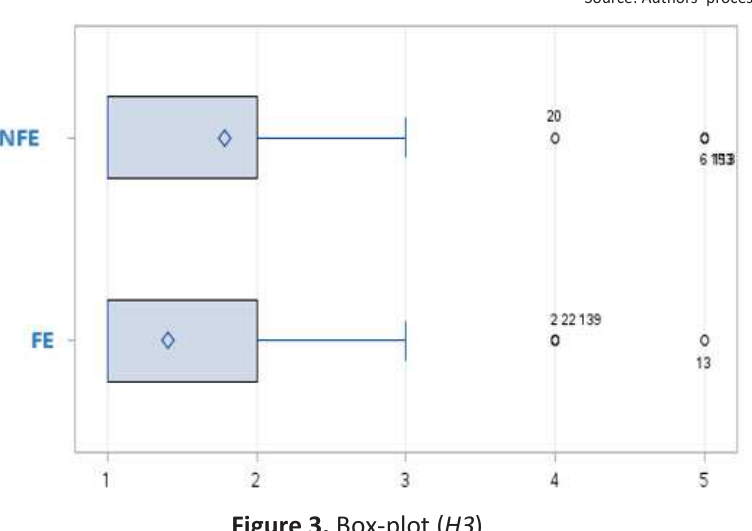
Figure 2. Box-plot ( H2 )